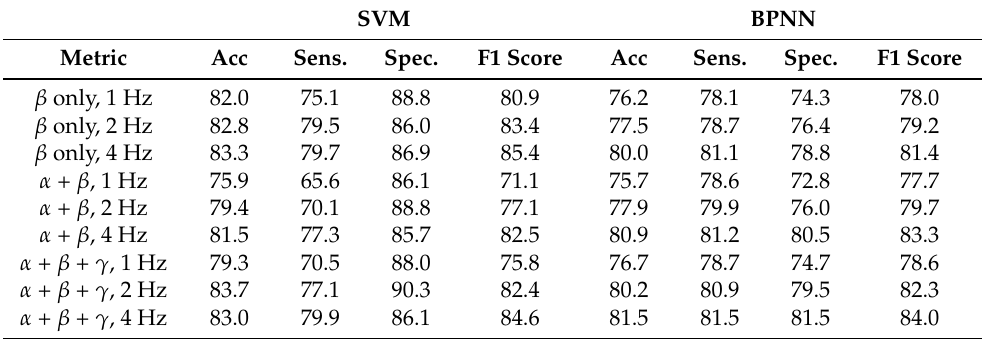
Table 5. Accuracy of aggregating both groups of subjects. The numbers given are percentage.